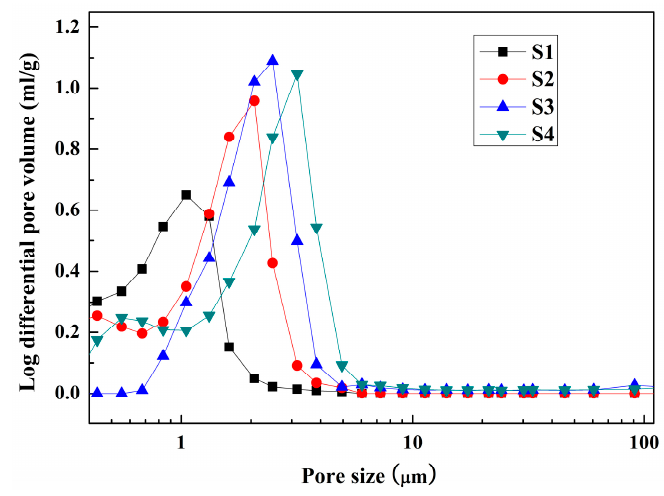
Figure 6. The pore size distribution of the samples with different ratios of starting powders and deionized water sintered at 1600 °C for 4 h.